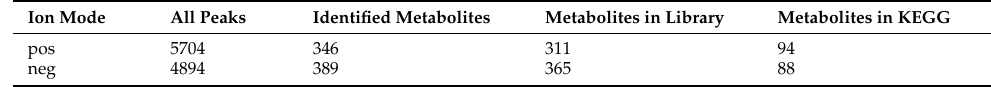
Table 1. Total ion count and identification statistics.